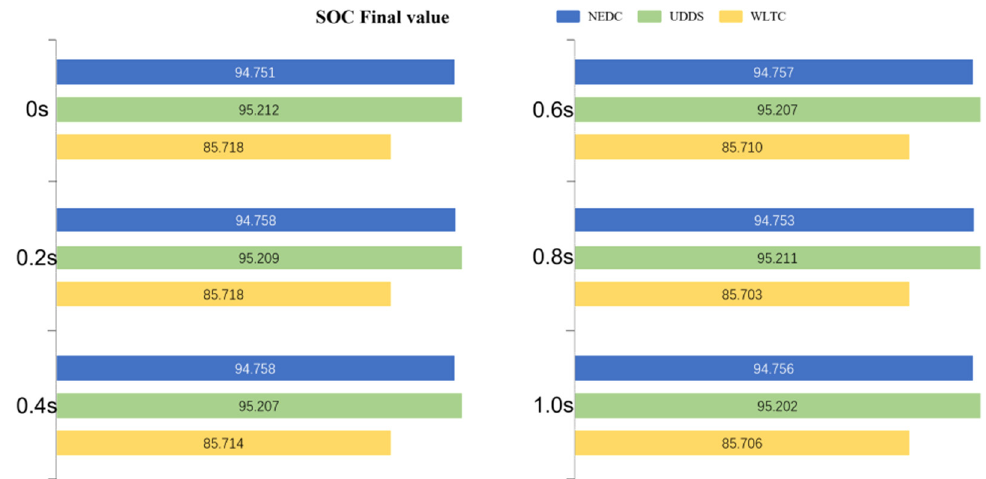
Figure 6. SOC values at different delay times.